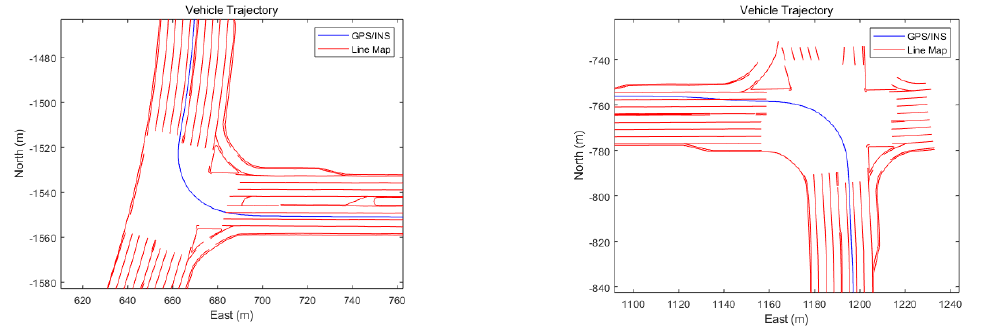
Figure 9. Real time-kinematic (RTK)/ inertial navigation unit (INS) position projected onto a high-precision digital map.